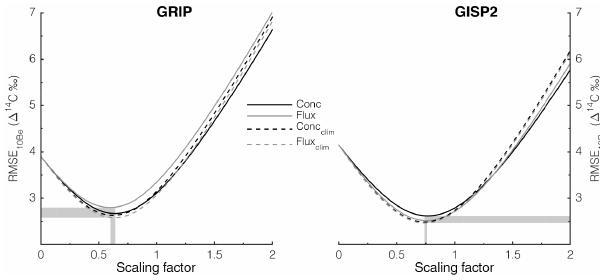
Figure 6. Rooted mean square error (RMSE 10 Be , see text) of syn- chronized centennial IntCal13 and 10 Be-based (cid:49) 14 C variations as a function of different 10 Be-scaling factors ( 14 C: 10 Be ratios). Re- sults for the different versions of the GRIP 10 Be record are shown on the left, while GISP2 10 Be-based results are shown on the right.